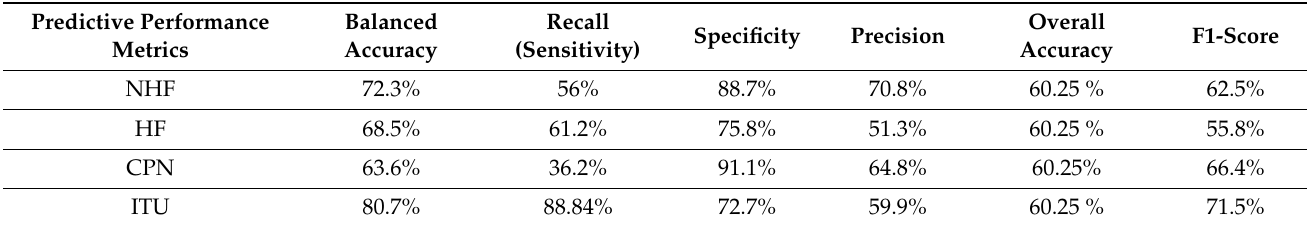
Table 11. Summary of the predictive performance results of BN developed to model MOoVS.